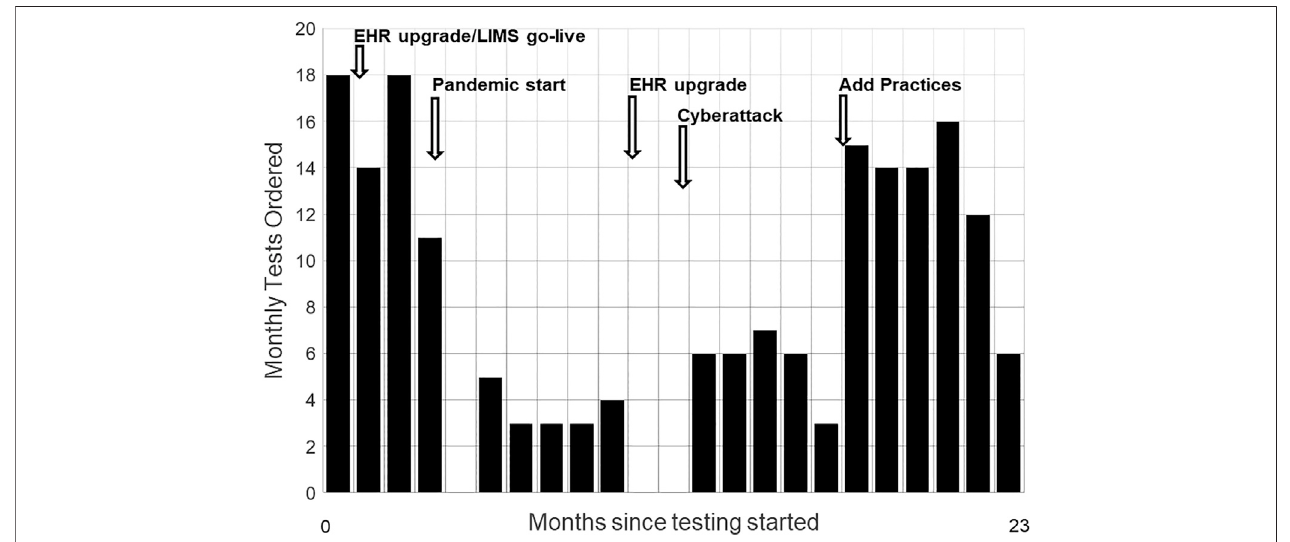
FIGURE2| MonthlyTestVolumesandKeyEvents.Monthlytestvolumesduringthe fi rst23 monthsoftesting,startingNovember2019.Disruptiveeventsincluded majorupgrades totheelectronic healthrecord(EHR), replacement ofthehospital ’ s laboratory information system (LIMS), the onsetofthe COVID-19 pandemic, anEHR upgraderequiringwidespreadstafftraining,and acyberattackthattookallinformationsystemsof fl ineforweeks.Addingasecondpractice groupwithits ownphysician champion increased volumes.